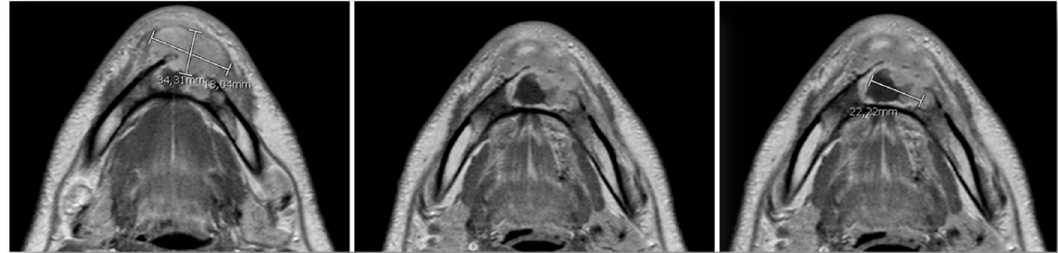
Figure 6. Preoperative MRI, multiple axial views. Vestibular extraosseous spread of the tumor was evident.